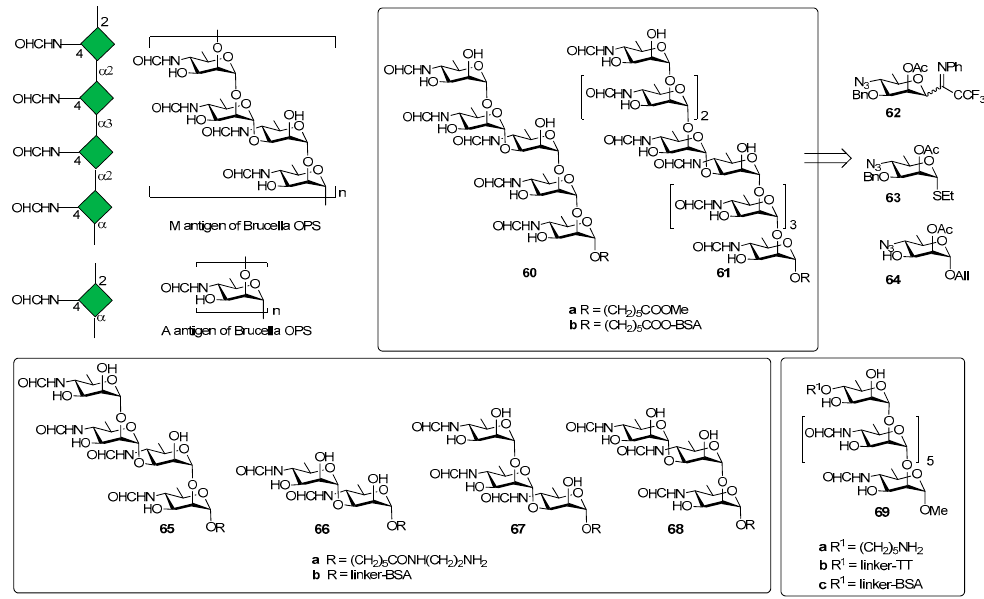
Figure 7. A and M antigenic determinants in Brucella OPS and oligomers synthesized by Bundle et al. [49].